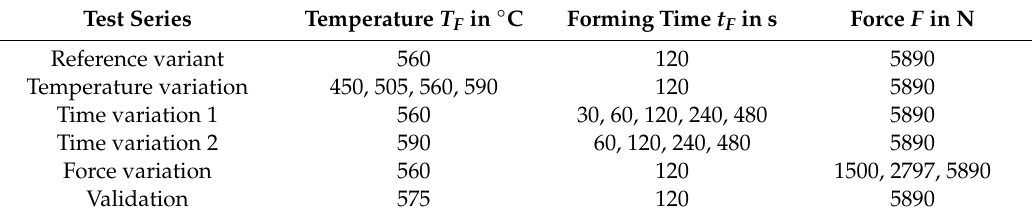
Table 1. Test matrix used for the dilatometer experiments; the values deviating from the reference configuration are highlighted in